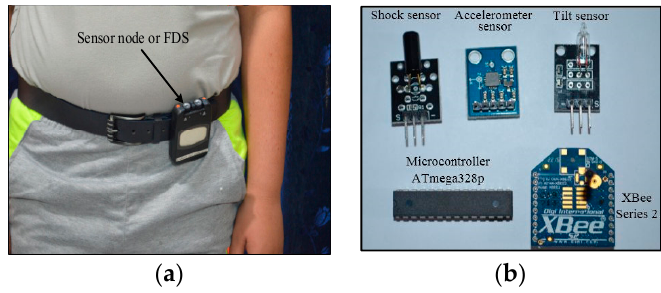
Figure 3. Proposed FDS ( a ) fastened to the subject individual’s waist, ( b ) its components.